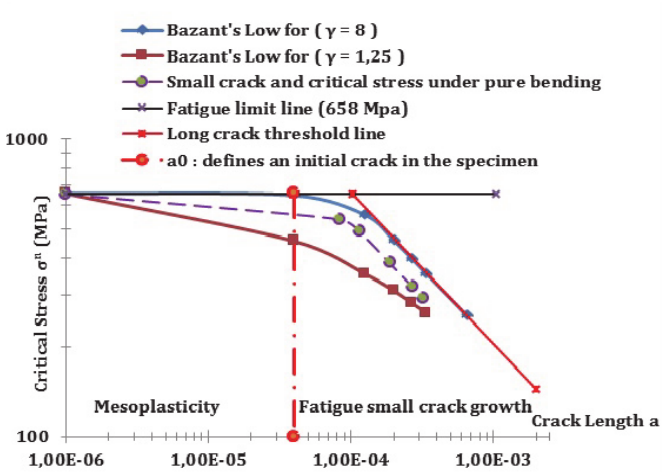
Figure 3: Small crack effect for 30NCD16 steel under critical